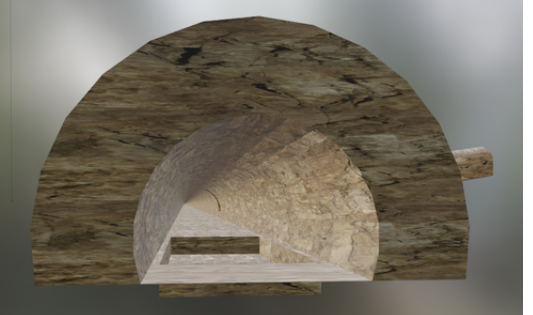
Figure 10. The tunnel scenario considered for simulations and real world tests. The rock trap (the ditch shown in the figure) along with an auxiliary tunnel